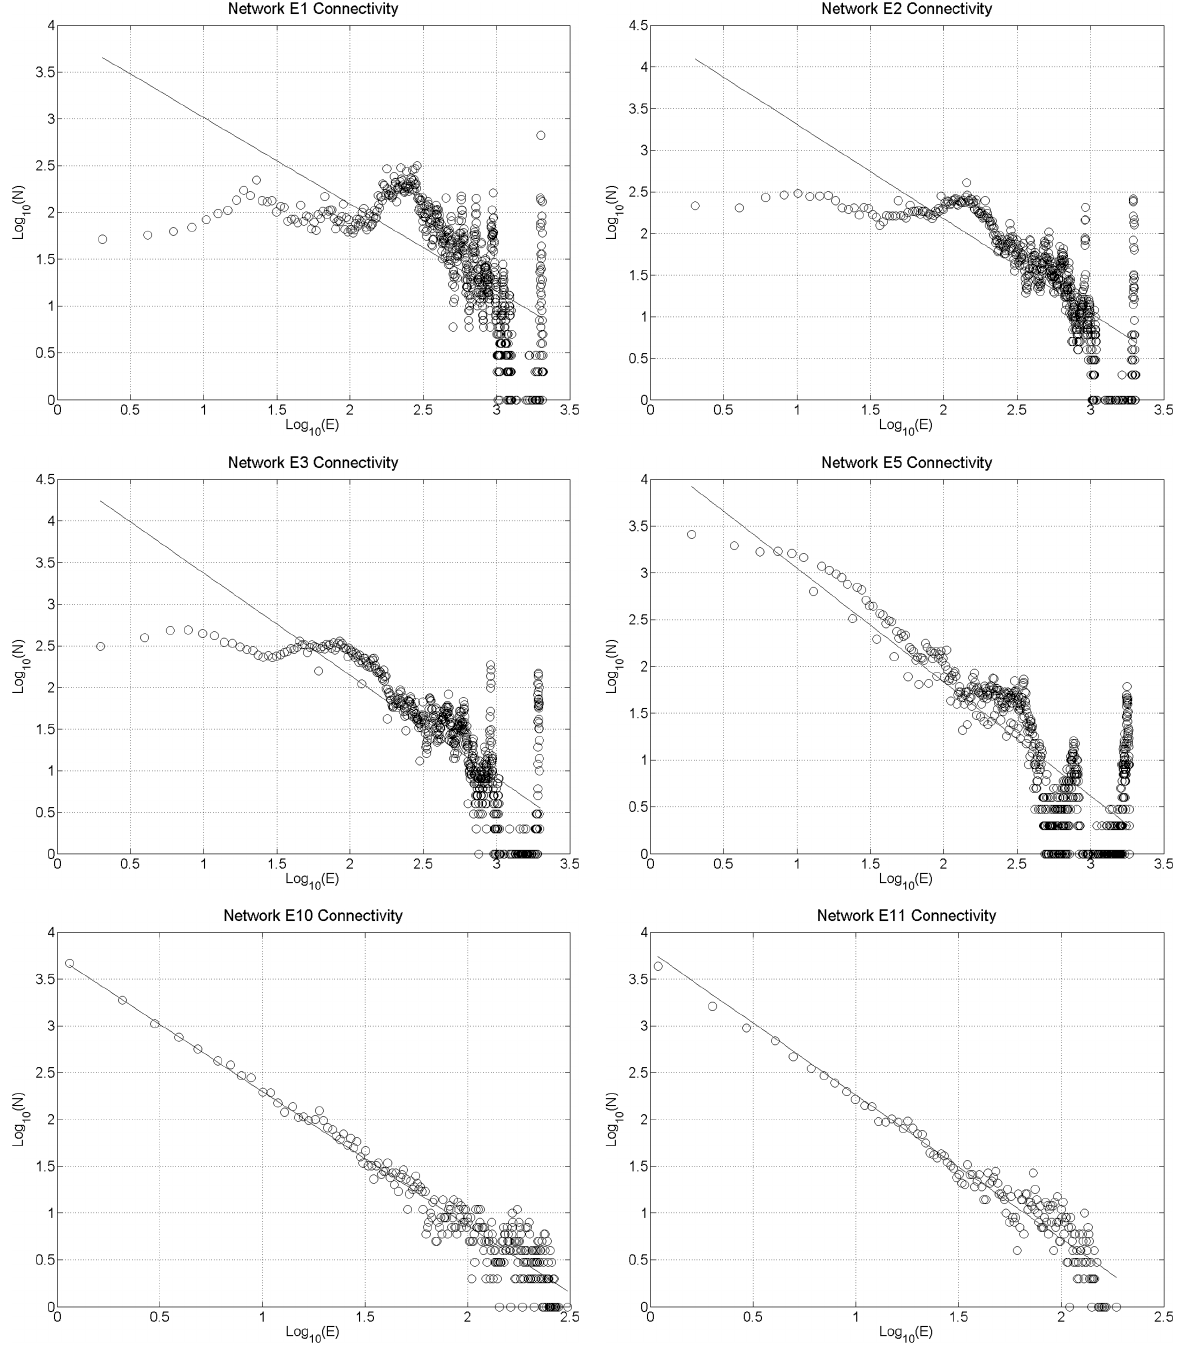
Fig. 4. Connectivity distribution for networks E1, E2, E3, E5, E10, and E11. N (on the Y axis) is the number of nodes that have a number E of edges (on the X